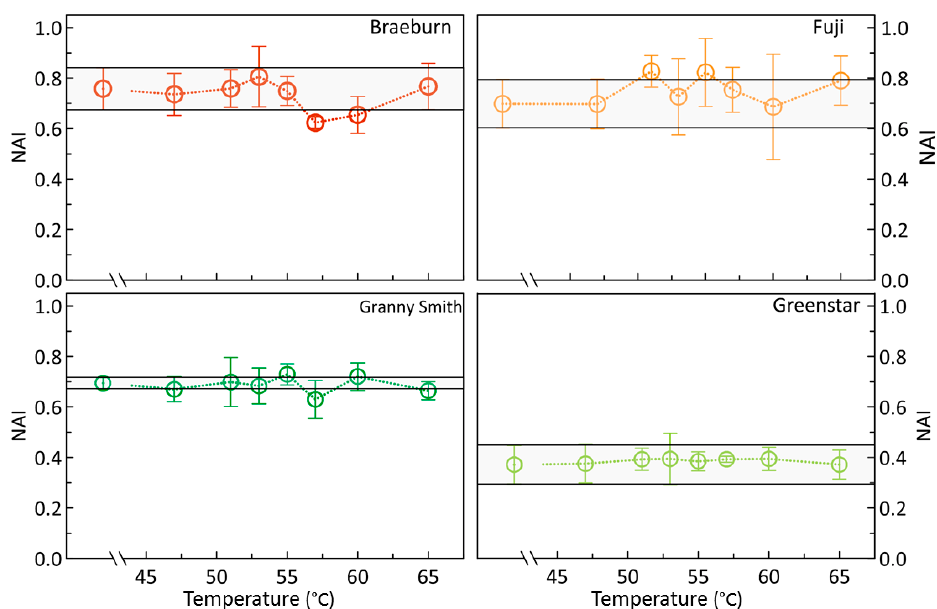
Figure 7. Means of the Normalized Anthocyanin Index (NAI) of ‘Braeburn’, ‘Fuji’, Granny Smith’, and ‘Greenstar’ apples, hot-water-treated in the temperature range of 46 to 65 ◦ C for 30 s. The light-grey horizontal bar indicates the standard deviation of results of the respective controls, roughly reflecting initial mean parameter variability.